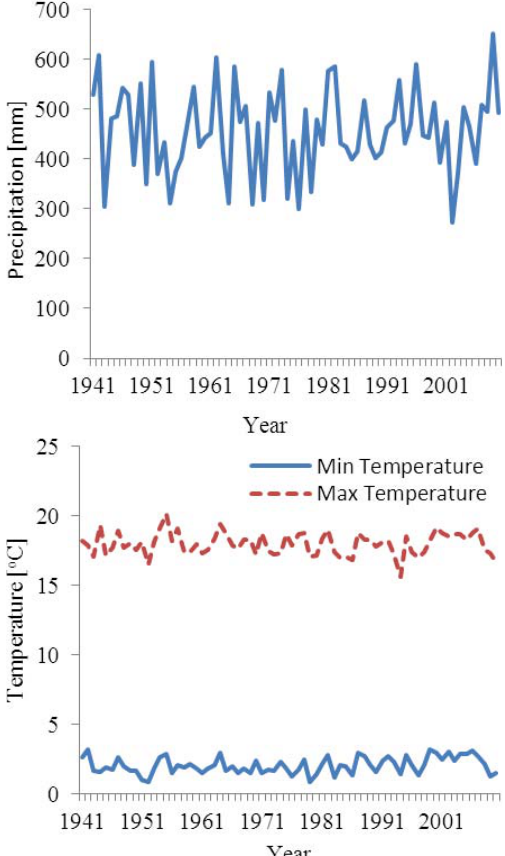
Fig. 4. Annual precipitation (left) and maximum/mininimum tem- perature (right) in FCB. The climate exhibits no significant change during the last several decades. The slight decrease in diurnal tem- perature range implies the impact of irrigation on land surface en- ergy